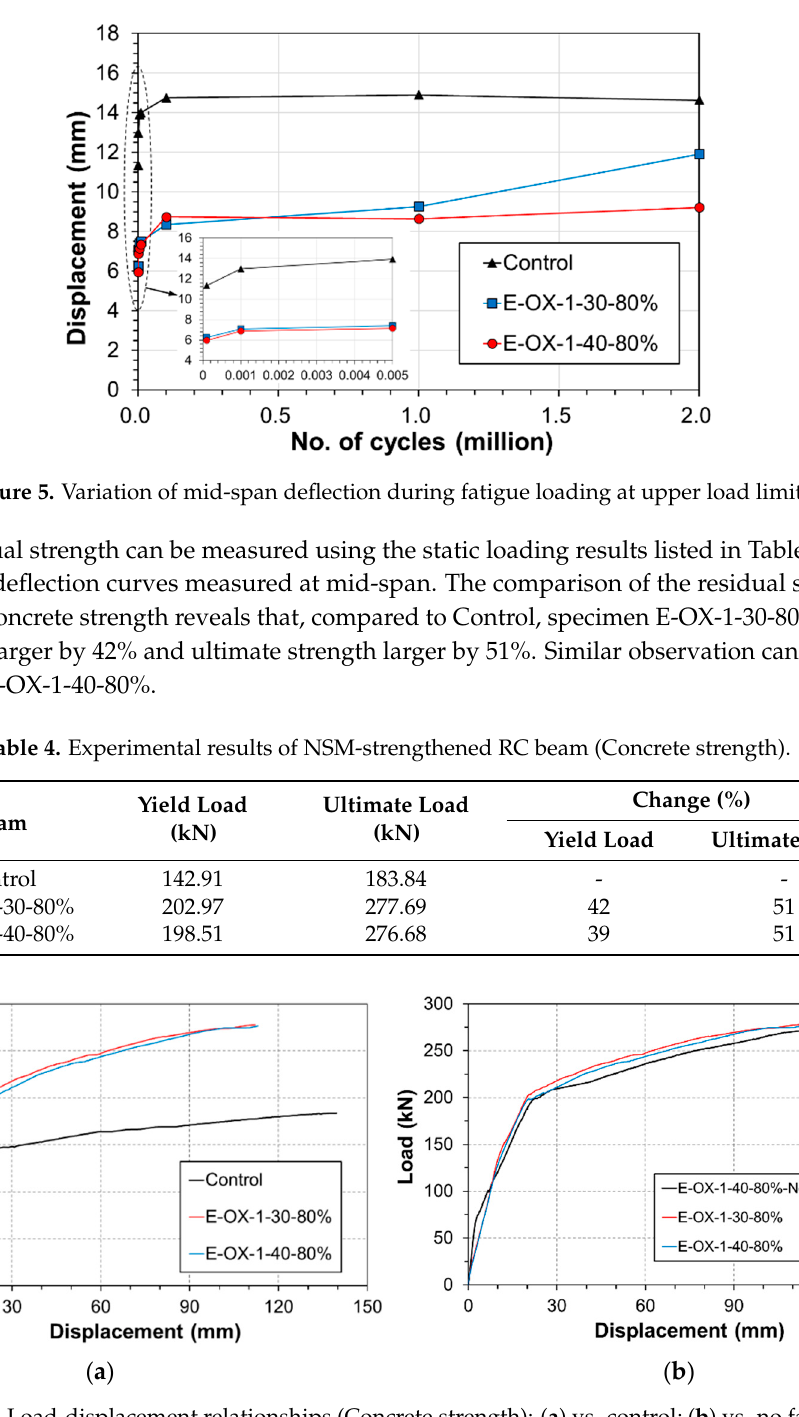
Figure 5. Variation of mid-span deflection during fatigue loading at upper load limit.